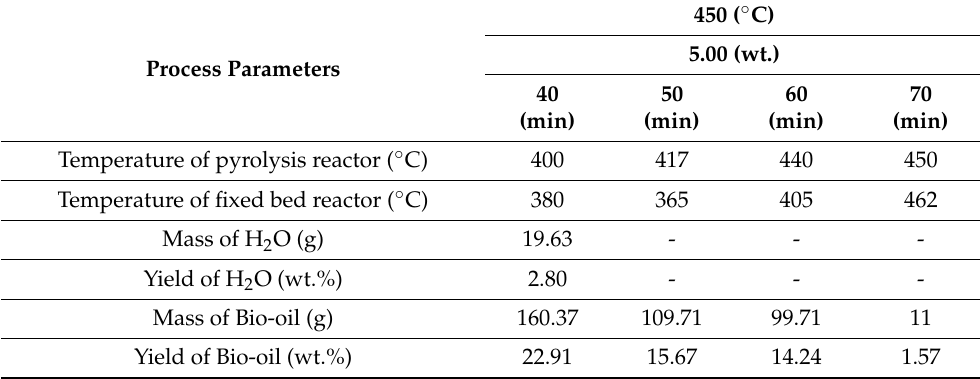
Table 5. Process parameters, mass balances, and partial yields of bio-oil and H 2 O obtained during course of reaction (50–80 min) of experiment using 5.0% catalyst.